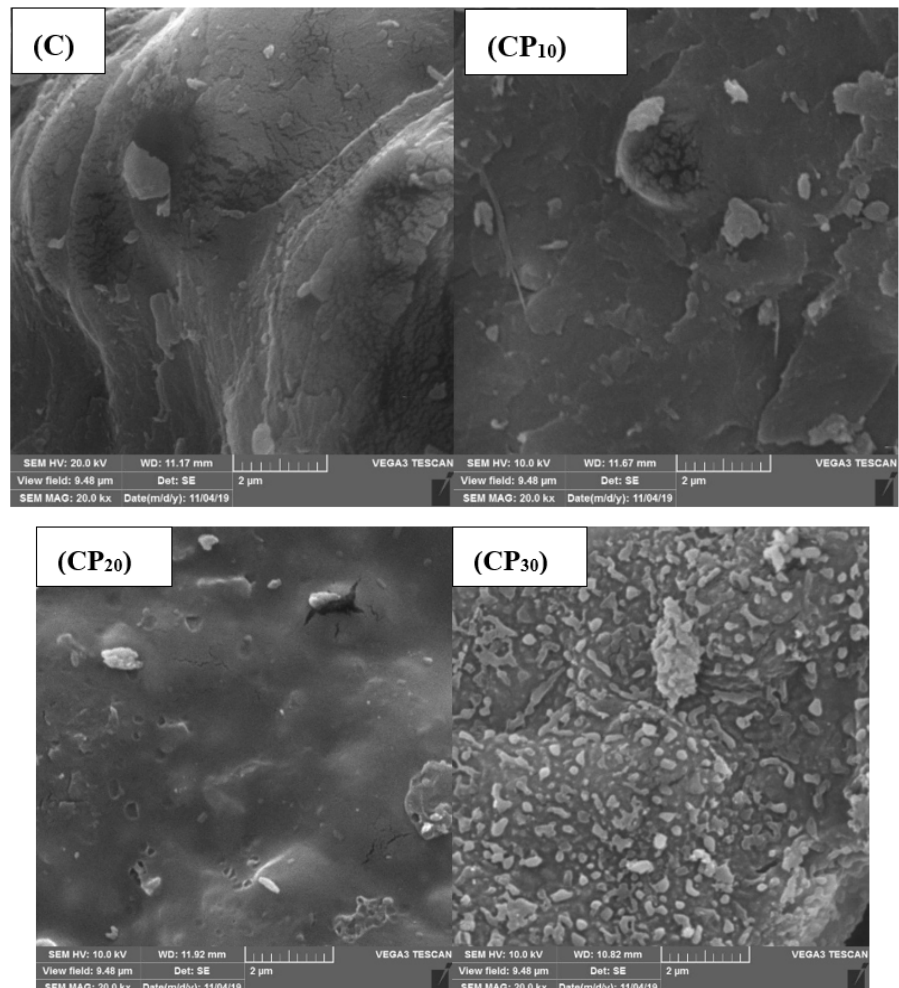
Figure 1. SEM micrographs ( × 20,000 magnification) of BSG powder treated by cold plasma (CP); C, CP 10 , CP 20 , and CP 30 indicate unmodified samples and those treated by CP for 10, 20, and 30 min,